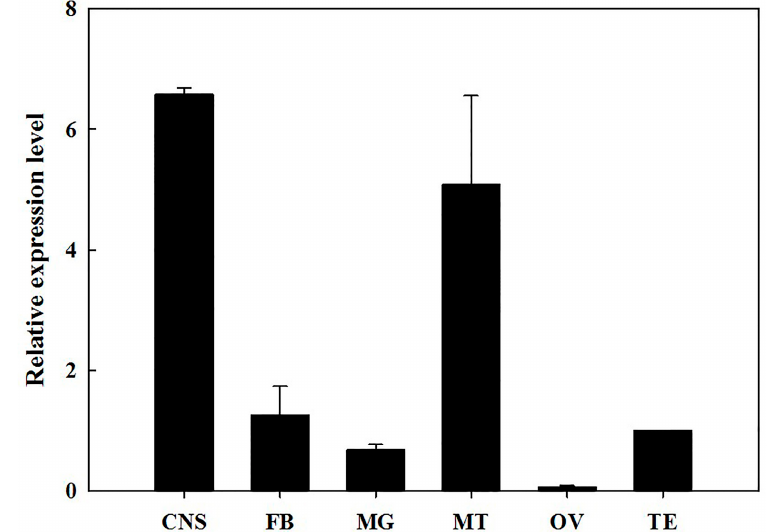
Figure 4. Relative expression levels of BdOct β R1 in various tissues of adults. The data shown are mean ± S.E. ( n = 3). Normalized relative to α -tubulin transcript levels. CNS: central nervous system;